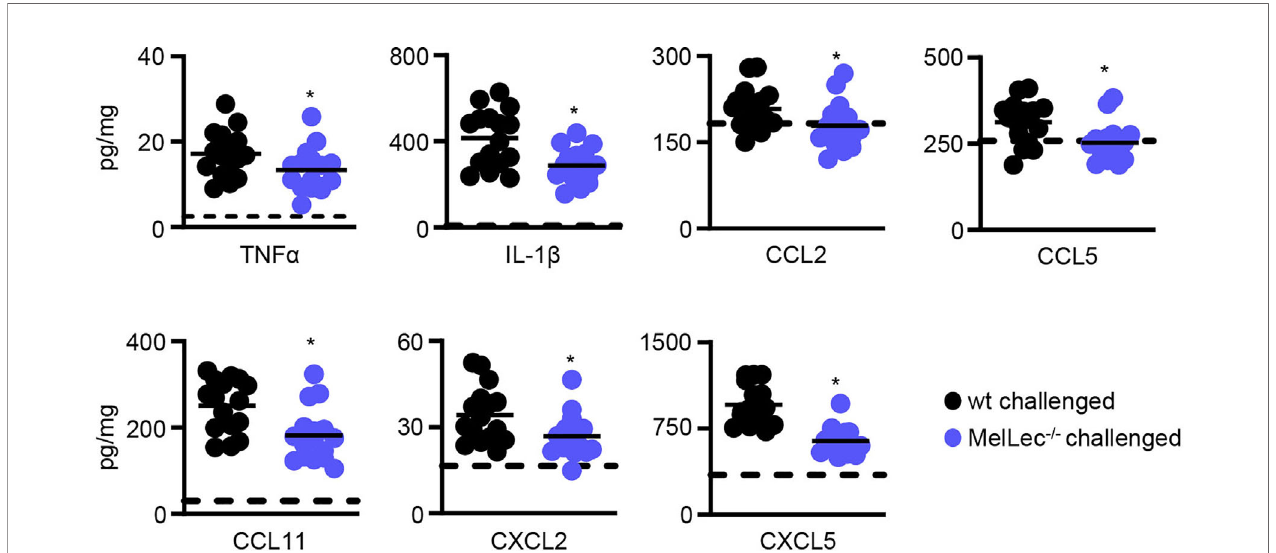
FIGURE 4 | Loss of MelLec leads to reduced pulmonary cytokine and chemokine levels. Cytokine and chemokine levels in the lungs of wild type (wt) and MelLec -/- mice on day 23 following sensitization and challenge with live Aspergillus fumigatus conidia. Shown are pooled data (with mean) from at least two independent experiments (n>15 mice). *p<0.05. Statistical signi fi cance between wt and MelLec -/- animals were determined using t-tests. Data from naïve mice are shown in Supplementary Figure 4